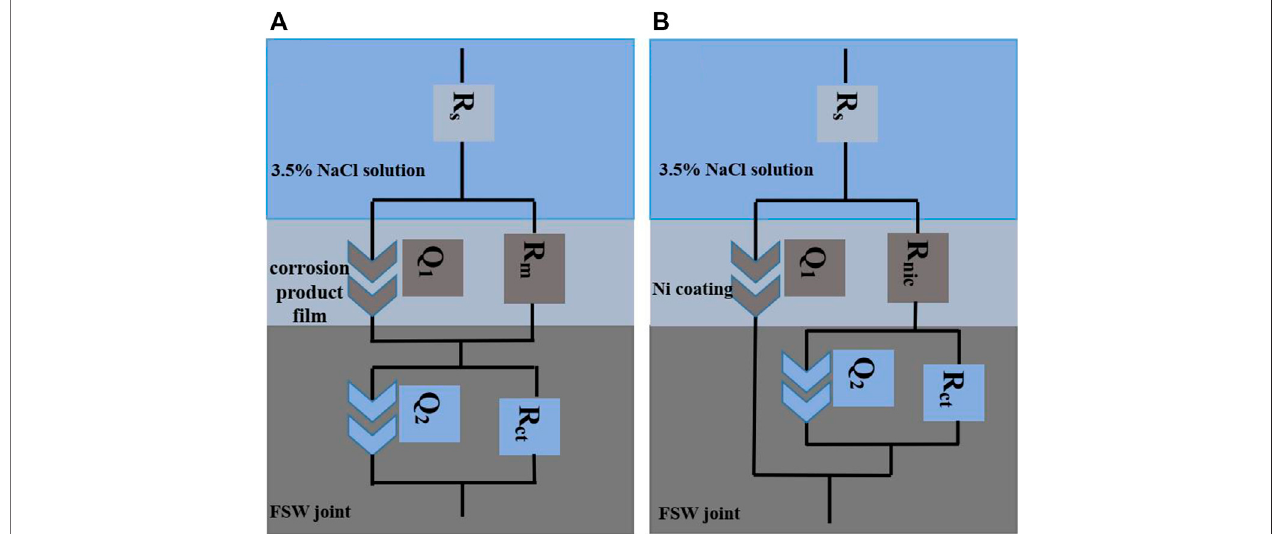
FIGURE 9 | Equivalent circuit diagrams [ (A) FSW joint and (B) Ni coating with different duty ratios].